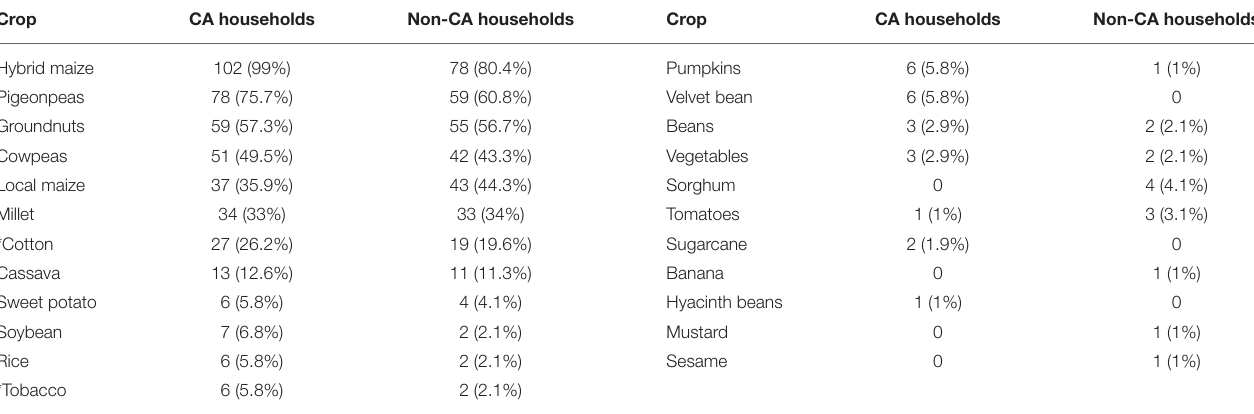
TABLE 4 | Crops grown by both CA and non-CA farmers by household. Crop CA